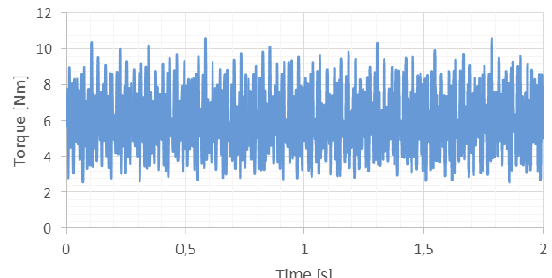
Fig. 3. Registered torque measurement at the speed of 2500 rpm and the oil temperature of 80 °C